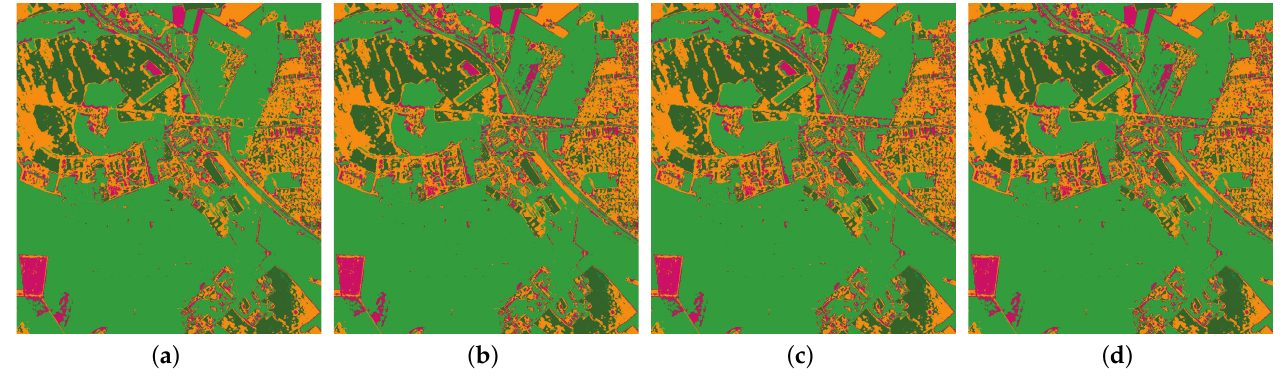
Figure A3. Classification results with different block sizes. ( a ) Result with block size as 100. ( b ) Result with block size as 120. ( c ) Result with block size as 150.